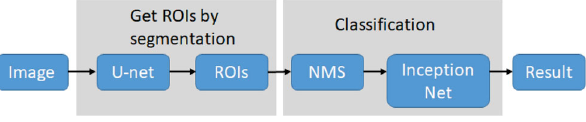
Fig. 2 Object detection pipeline.